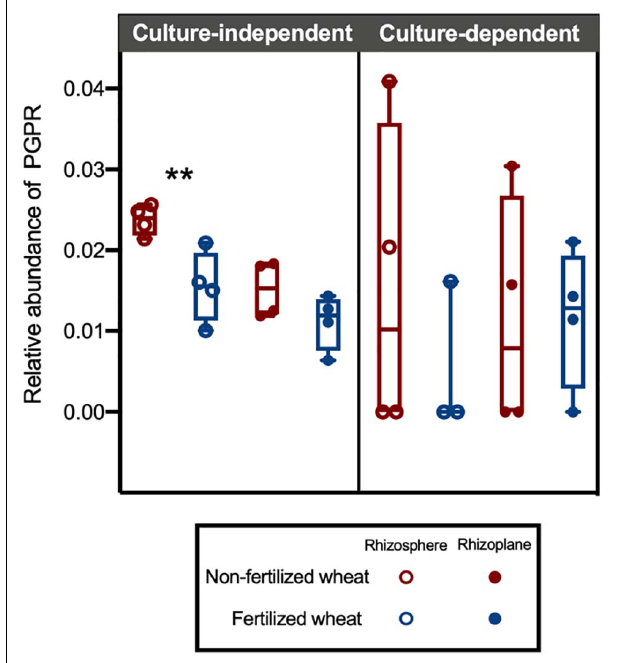
FIGURE 7 | Box plots showing relative abundance of ASVs identified as putative plant growth-promoting rhizobacteria (PGPR) in culture-independent and -dependent isolate datasets. A PGPR database was created from 16S rRNA gene sequences from culturable bacterial isolates with acquisitional traits for key plant nutrients. Each point represents the proportion of ASVs that were identified as Bacteria in CI and CD datasets, with median (line) and hinges at first and third quartiles (25th and 75th percentiles). Significant differences as determined by post hoc multiple comparison tests with Šidák correction are shown by “**” for p <